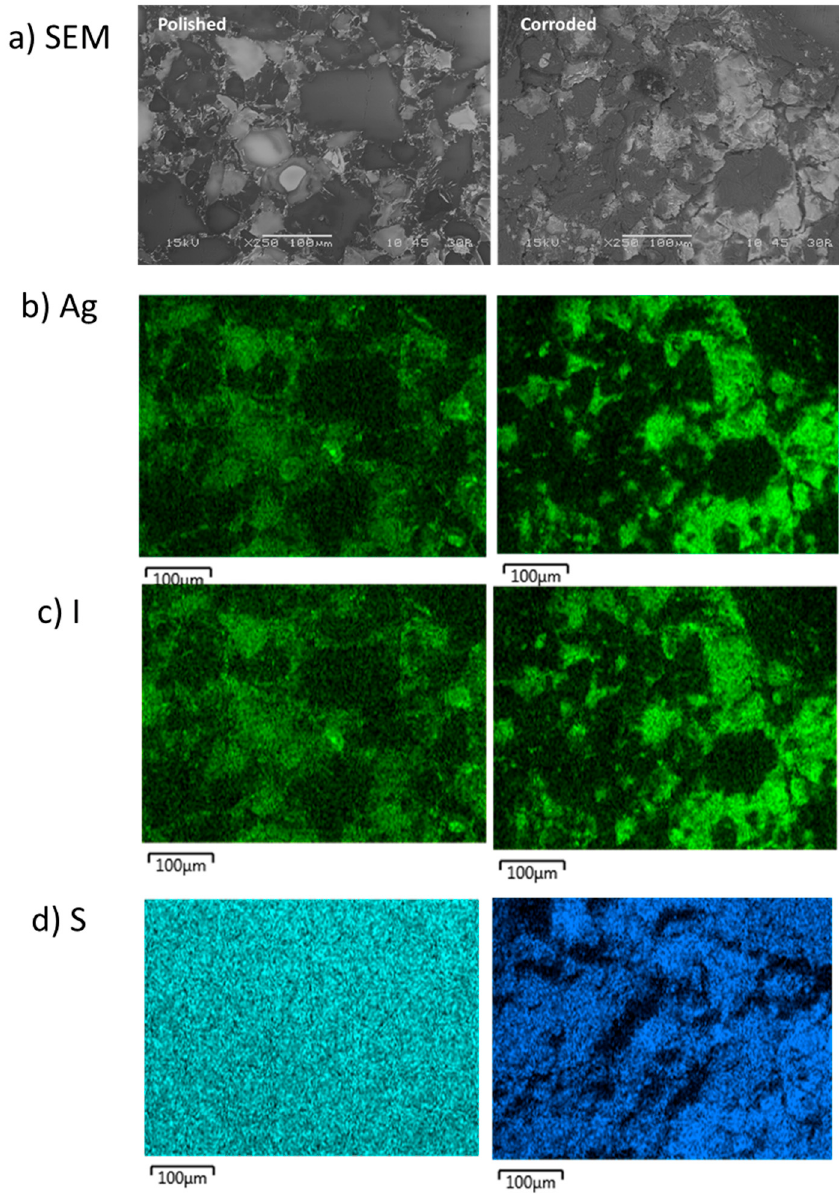
Figure 16. ( a ) SEM micrographs of the SPS-2 sample before (left) and following (right) SPFT testing at pH 11; and the corresponding EDS maps of: ( b ) Ag; ( c ) I; and ( d ) pH 11; and the corresponding EDS maps of: ( b ) Ag; ( c ) I; and ( d ) S.